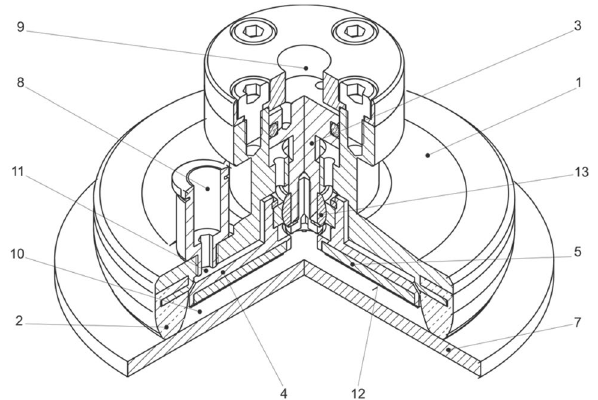
Fig. 27 Gripping element (with support plate orientation compen- sation)